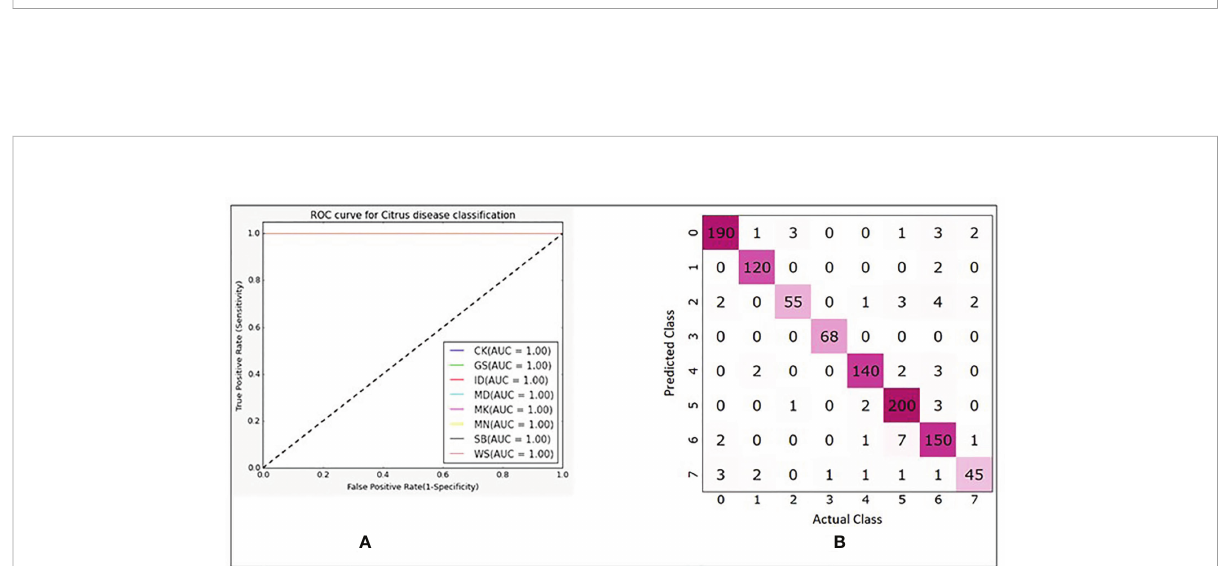
FIGURE 7 (A) ROC plots with corresponding AUC values for each class. (B) Confusion matrix showing number of correctly and misclassi fi ed images for each class (refer to Table 1 for class numbers along x and y